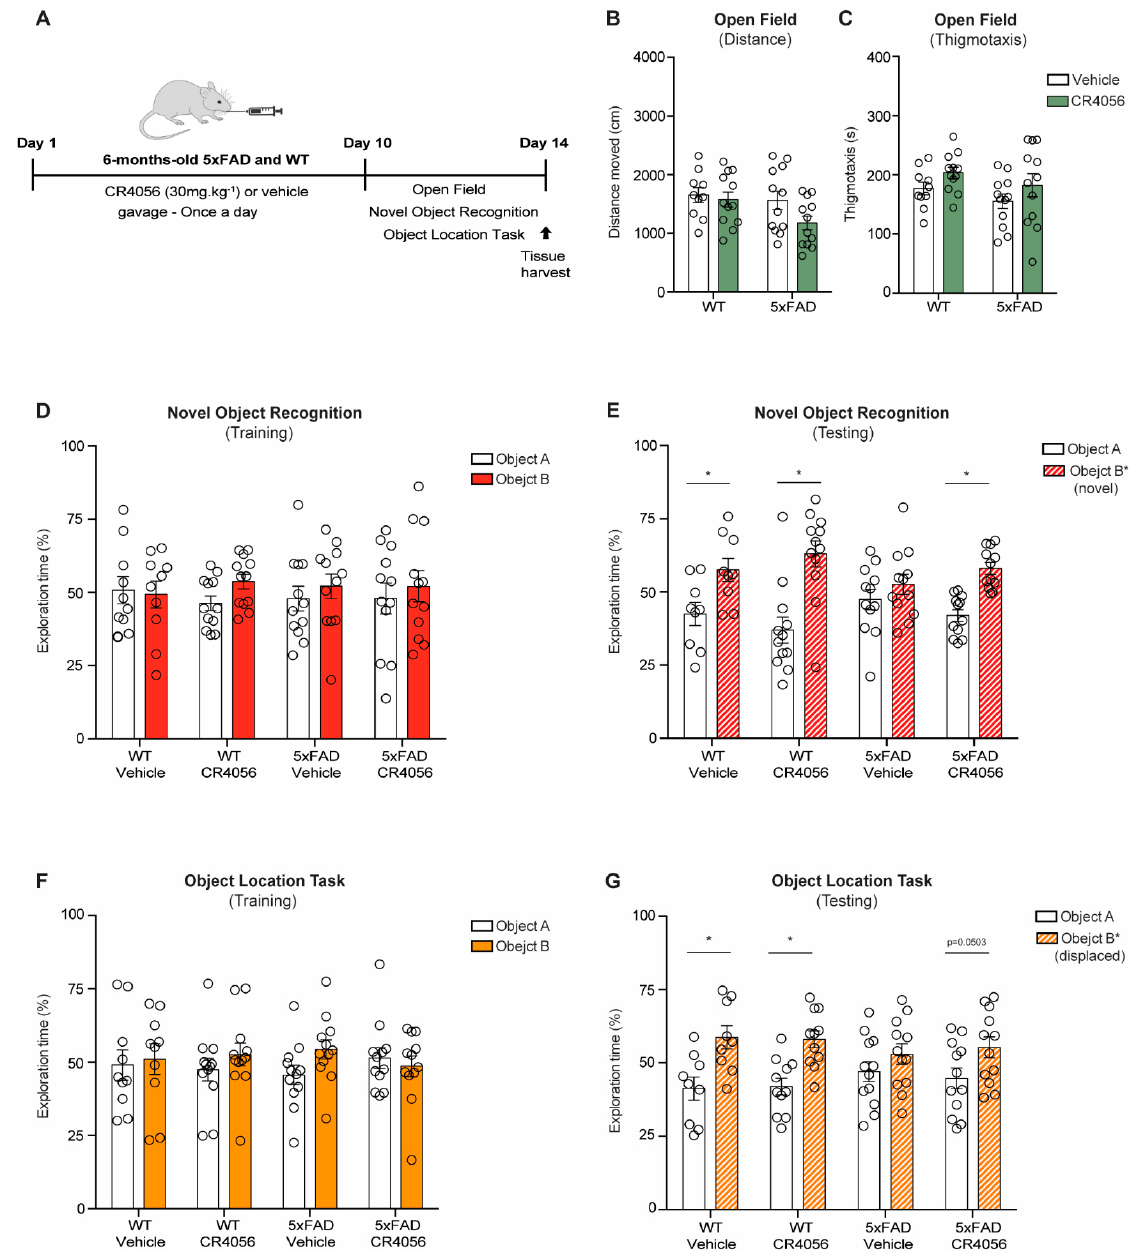
Figure 2. Sub-chronic administration of CR4056 improves recognition memory in 6-month-old 5xFAD mice and not in wild-type (WT) controls. ( A ) Schematic diagram of CR4056 treatment timeline. ( B , C ) Measurement of distance moved ( B ) and thigmotaxis ( C ) by open field test (OF) in